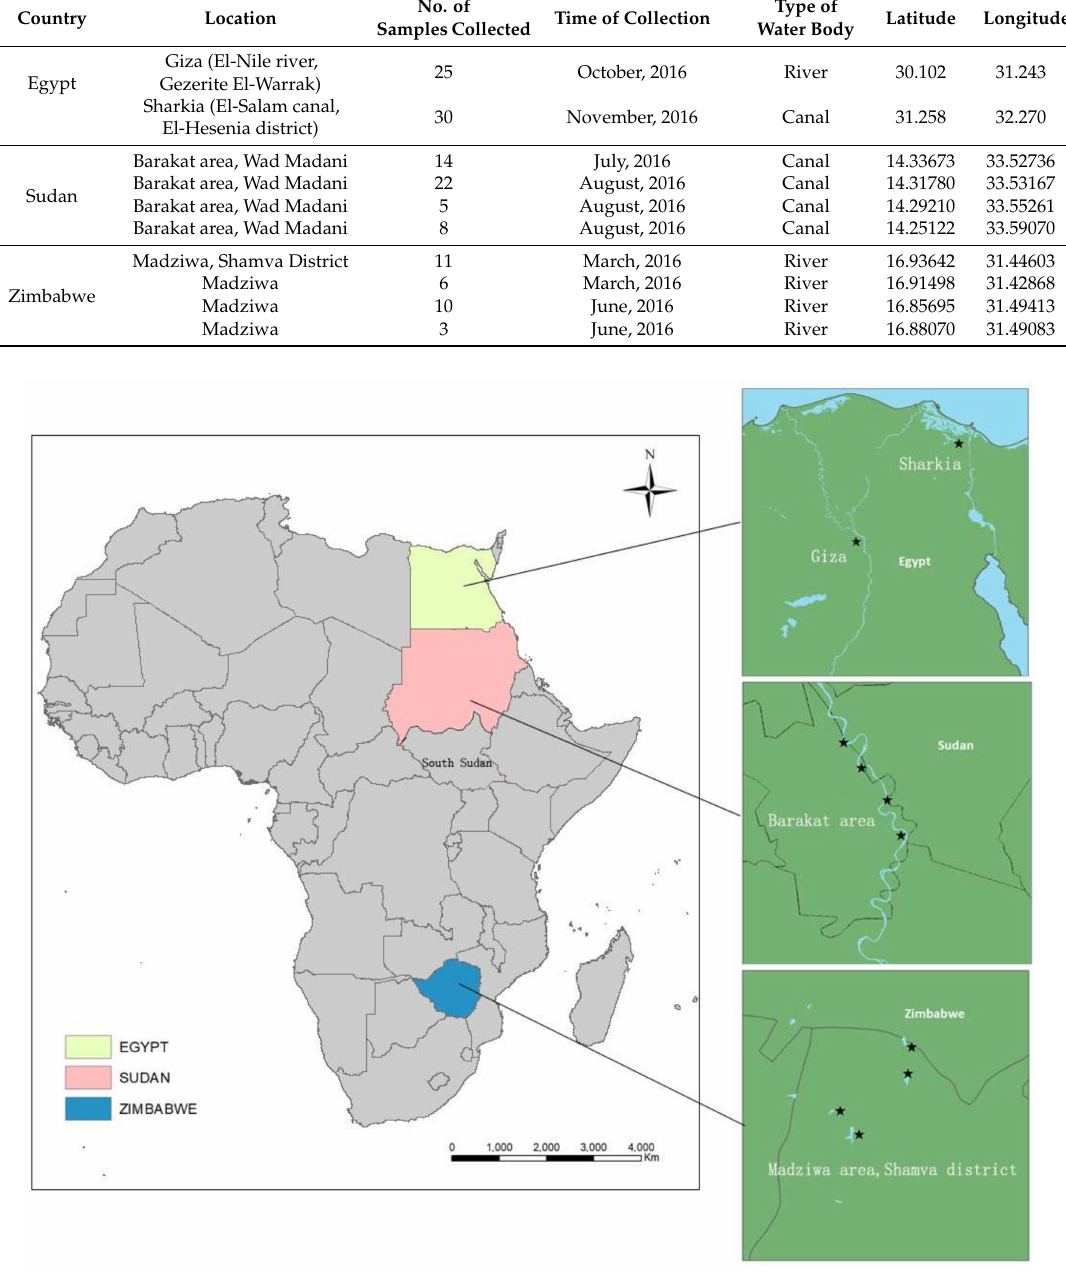
Table 1. Geographic coordinates of the study areas.